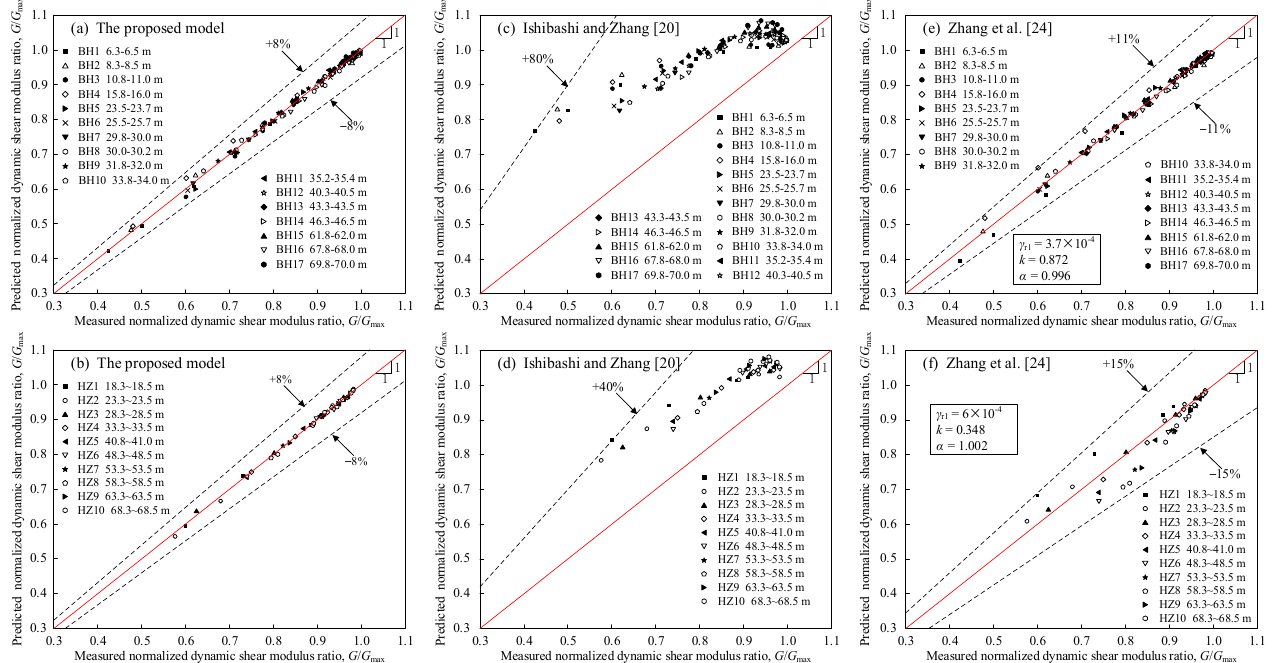
1.1 Measured normalized dynamic shear modulus ratio, G / G max Figure 12. Comparison of the predicted performance of G / G max values: ( a – b ) the performance of the Figure 12. Comparison of the predicted performance of G / G max values: ( a , b ) the performance of the proposed model; ( c – d ) the performance of the Ishibashi and Zhang’s [20] model; ( e – f ) the perfor- proposed model; ( c , d ) the performance of the Ishibashi and Zhang’s [20] model; ( e , f ) the performance mance of the Zhang et al.’s [24] model. of the Zhang et al.’s [24]